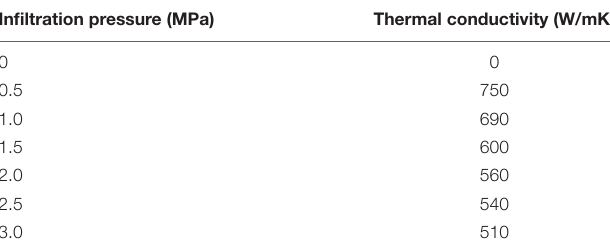
TABLE 7 | Infiltration pressure v/s thermal conductivity (at 850 ◦ C) (Zhang et al., 2014). Infiltration pressure (MPa) Thermal conductivity